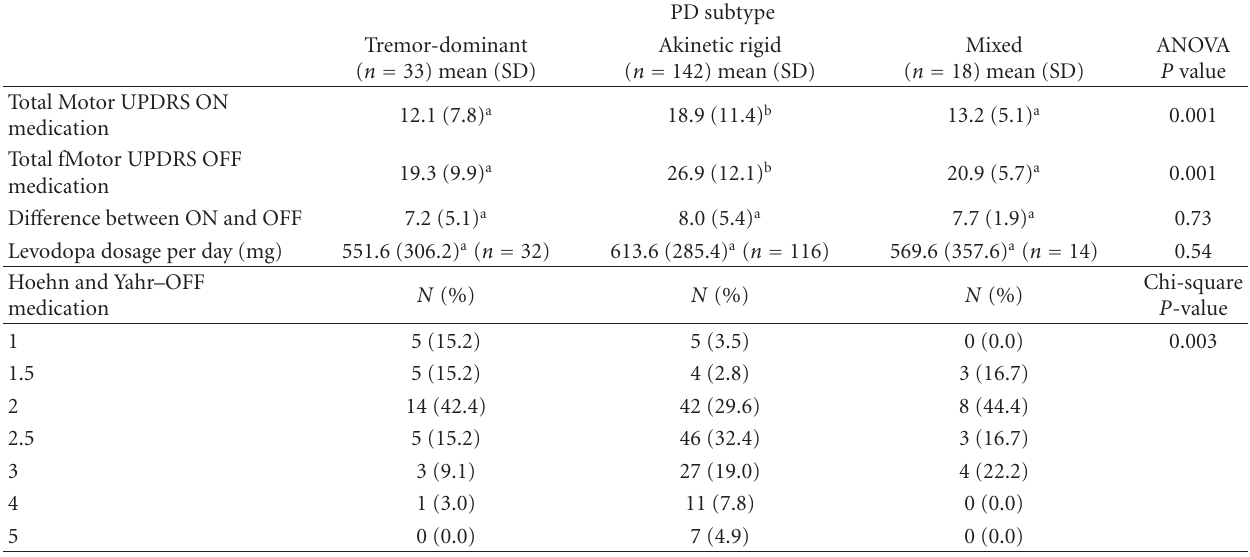
Table 4: Total Motor UPDRS ON and OFF medication by PD subtype ( n =